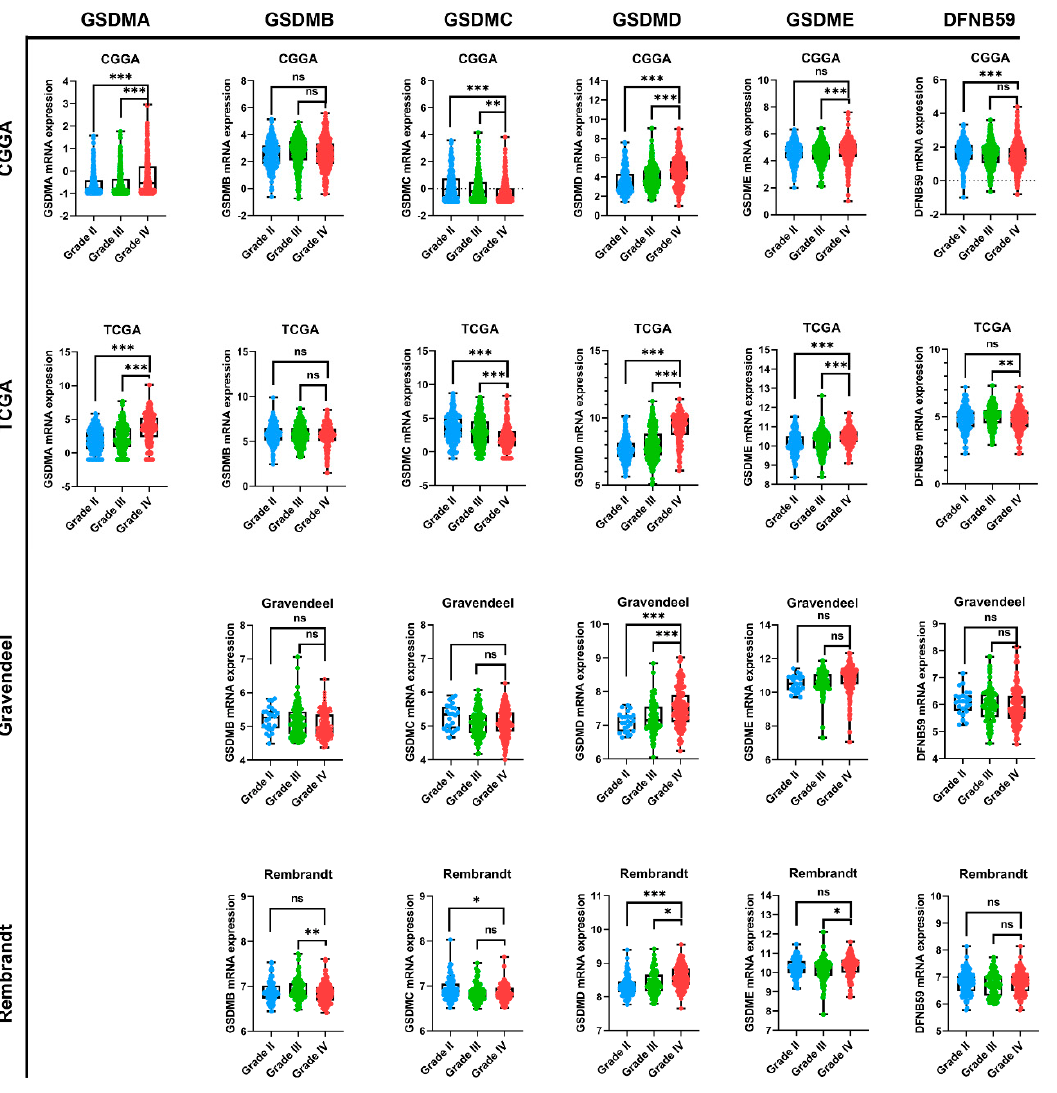
Figure 2. GSMDs mRNA expression associated with glioma WHO grade. Four public datasets, namely TCGA, CGGA, Gravendeel and Rembrandt were used to investigate GSDMs expression in glioma. All data were downloaded from the GlioVis platform. GSDMA expression was missing in Gravendeel and Rembrandt. The number of Grade I patients was too small and did not affect the final results. * p < 0.05, ** p < 0.01. *** p < 0.001. ns, no significance.